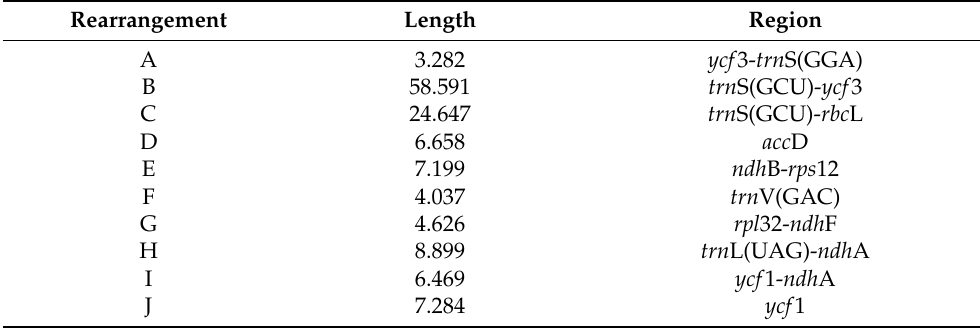
Table 2. Rearrangement blocks in the result of progressiveMauve among fourteen species (ten Vanilloideae species and four Apostasioideae species were